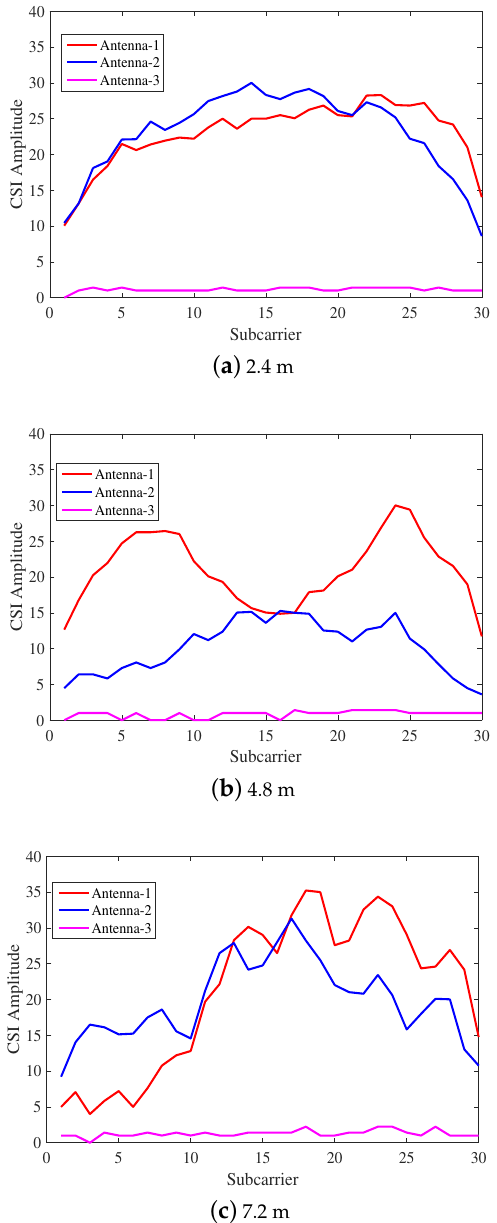
Figure 3. The CSI amplitude changes under different distances of indoor complex